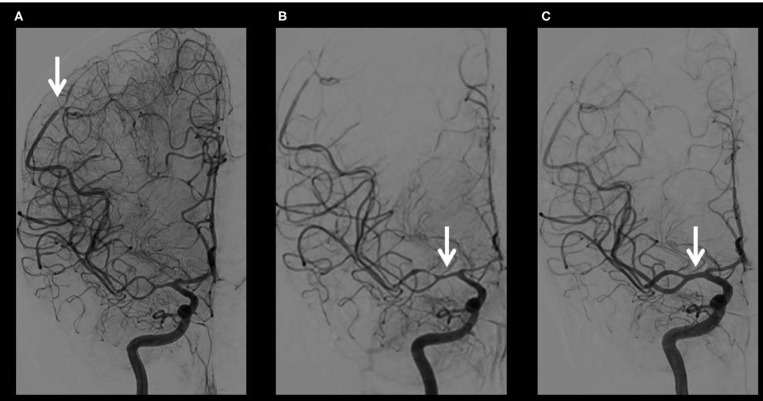
Illustration of cerebral digital subtraction angiographies (DSA) over time and response to treatments. (A) Cerebral Digital Subtraction Angiography (DSA) on Day 5 evidencing widespread arterial vasoconstrictions predominantly in brain distality (white arrow). (B) Cerebral DSA on Day 12 showing worsened distal and proximal (white arrow) arteries stenoses before intraarterial treatments. (C) Cerebral DSA on Day 12 showing distal and proximal (white arrow) arteries stenoses resolution after intraarterial injection of nimodipine and balloon angioplasty on proximal stenosis.